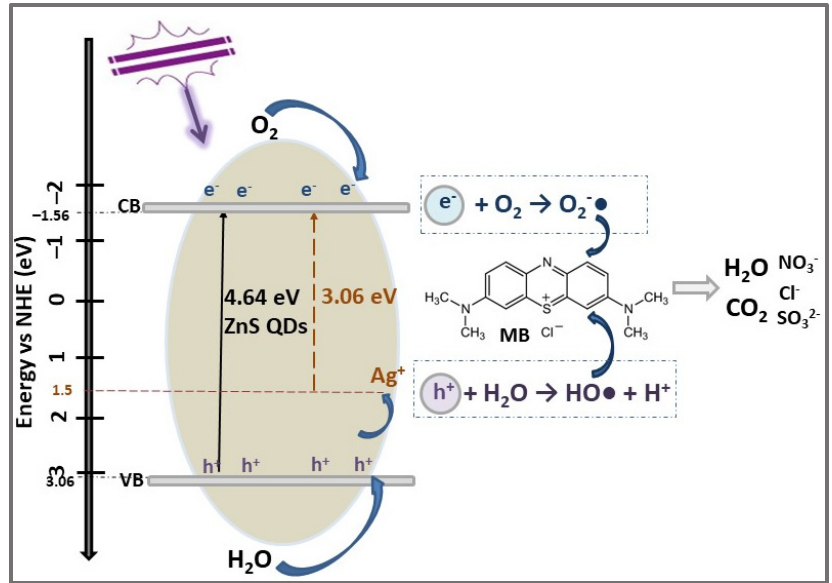
Figure 2. The photocatalytic degradation mechanism of MB dye using Ag-doped ZnS QDs photocatalyst under UV light irradiation for 3 h.